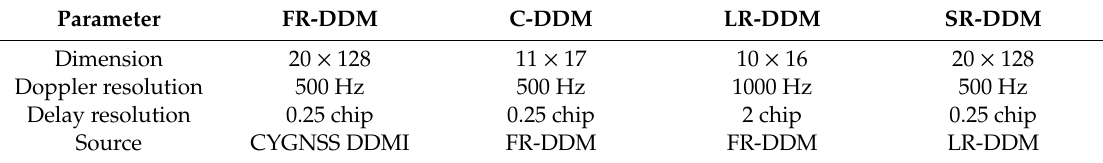
Figure 1 . The sample points on the fully resolved delay-Doppler map (FR-DDM) used to produce the low-resolution DDM (LR-DDM). The red dot indicates the sample points to form the LR-DDM. The black rectangle represents the grid of the FR-DDM. Table 1. Summary of delay-Doppler map (DDM) characteristics.